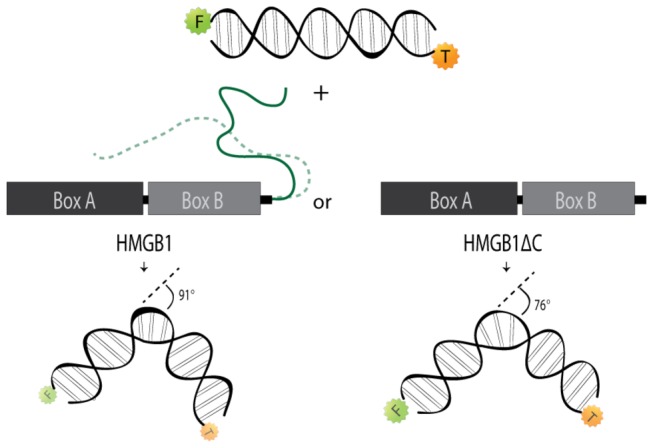
Schematic representation of HMGB1-mediated DNA bending.A 20-bp oligonucleotide labeled with FAM (green star, F) and TAMRA (orange star, T) fluorophores in the presence of HMGB1 or HMGB1∆C undergoes bending at different angles, measured by the distance between these two fluorophores. Bending angle values were obtained using the two-kinked model. The difference observed in size and color intensity of the fluorophores molecules is proportional to their emission quenching. The acidic tail of HMGB1 and its interaction with other part of the molecule are represented by green and dashed lines, respectively.